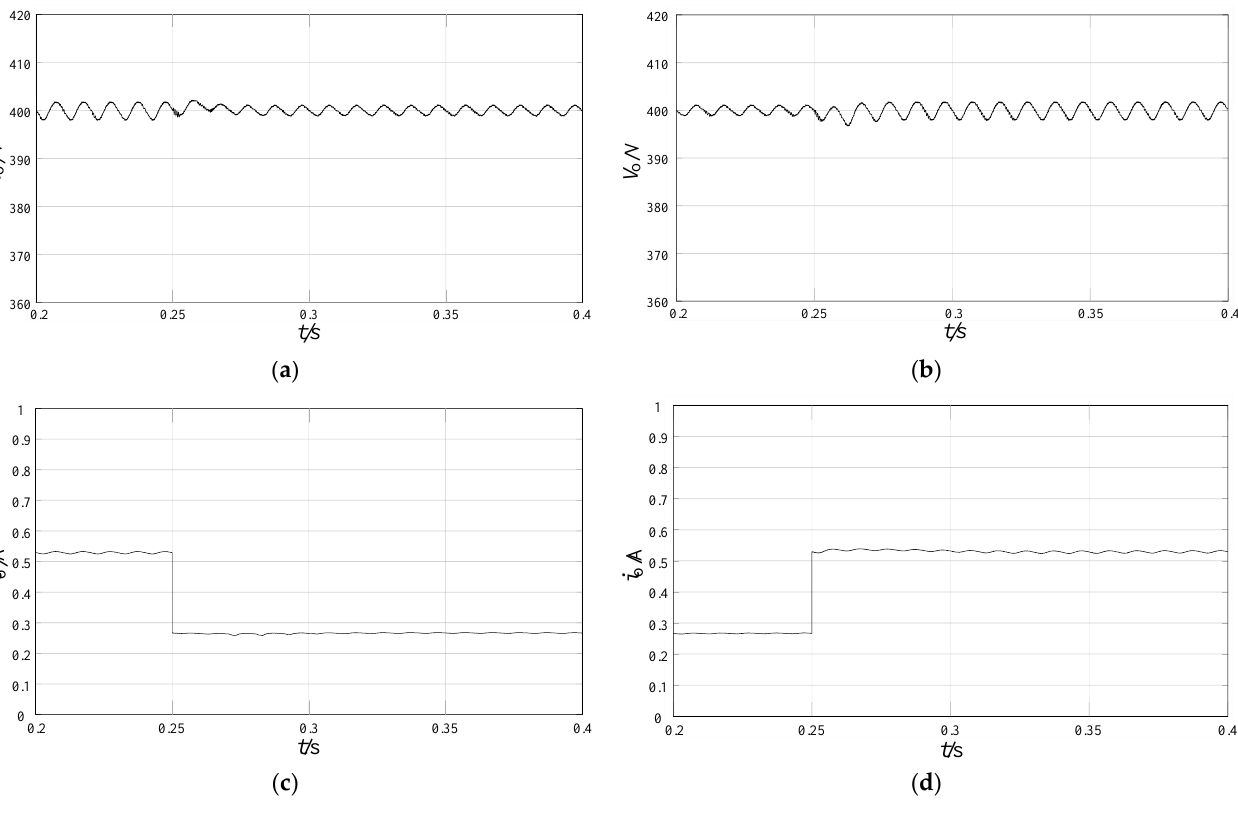
Figure 15. Output voltage and current waveforms when the load is abrupt: ( a ) voltage waveform at full load burst to half load; ( b ) voltage waveform at half load burst to full load; ( c ) current waveform at full load burst to half load; ( d ) current waveform at half load burst to full load. Figure 16 shows the inductor current waveforms of the power decoupling circuit when different control strategies are used. As shown in Figure 16a, the conventional double closed-loop control is used, which has limited tracking capability in the inner loop of the current, and in Figure 16b, the inner loop of the current is controlled by model current prediction control, which, as can be seen from the figure, has a better current tracking effect and can make the bidirectional buck/boost converter absorb two times the ripple component of the power frequency and reduce the ripple at the